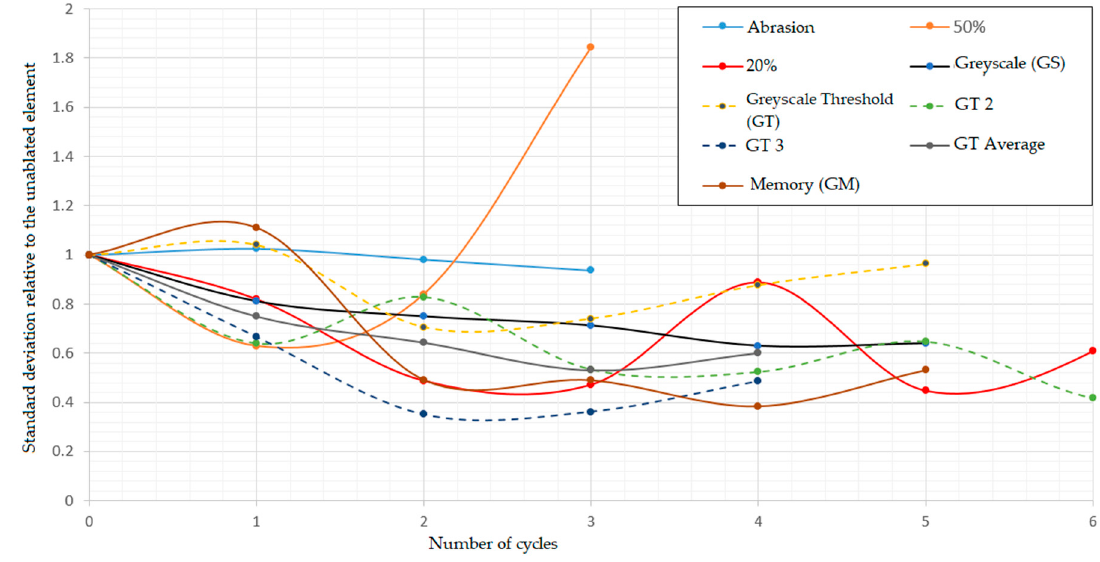
Figure 21. Graph of the standard deviation of the surface temperature relative to the initial standard deviation of the element.